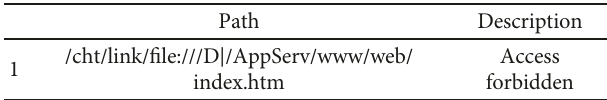
Figure 11: Test result of the emulation mode with hop (request distribution). Table 6: Test result of the emulation mode with hop (errors and exceptions).